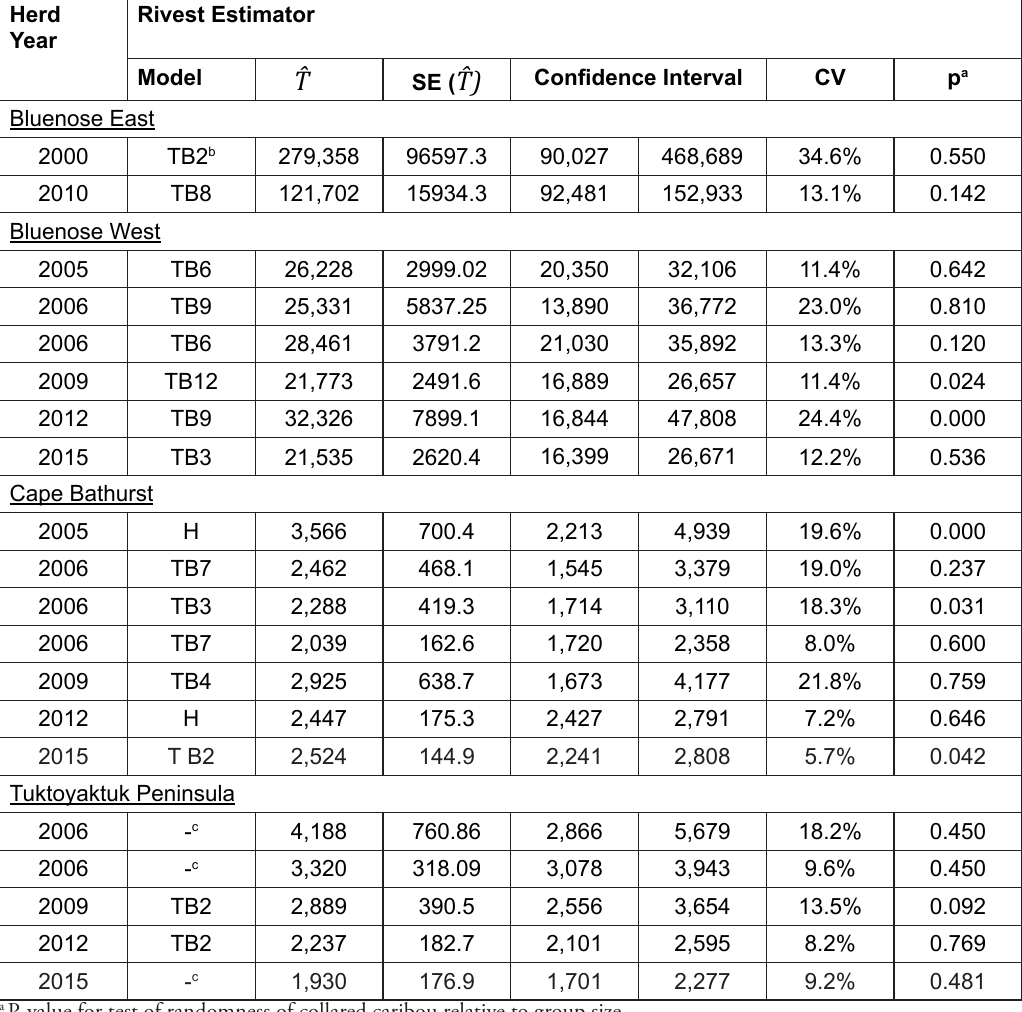
Table 2. Summary of herd estimates using the Rivest estimator for post-calving surveys used in meta-analysis for caribou herds in the Northwest Territories and Nunavut, Canada, 2000-2015. The model used for estimates had the highest likelihood score of models considered. Further details on each analysis are given in Appendix 1. Estimates with the lowest CVs and highest likelihoods were the preferred